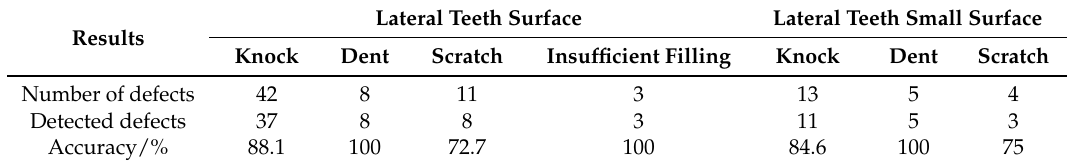
Table 6. Lateral surface inspection of gear F 6 .